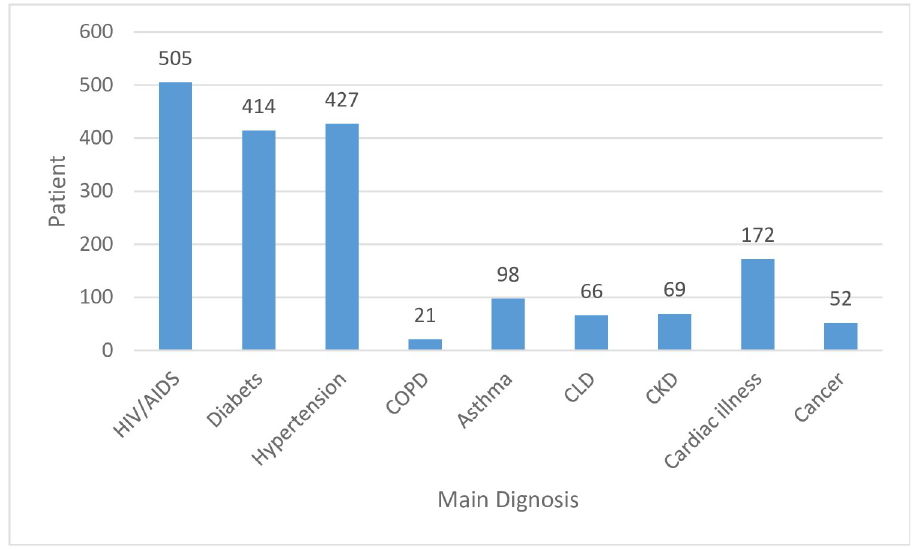
Fig 3. Type of chronic disease in patients on chronic disease follow-up at Amhara region, Ethiopia, 2021.